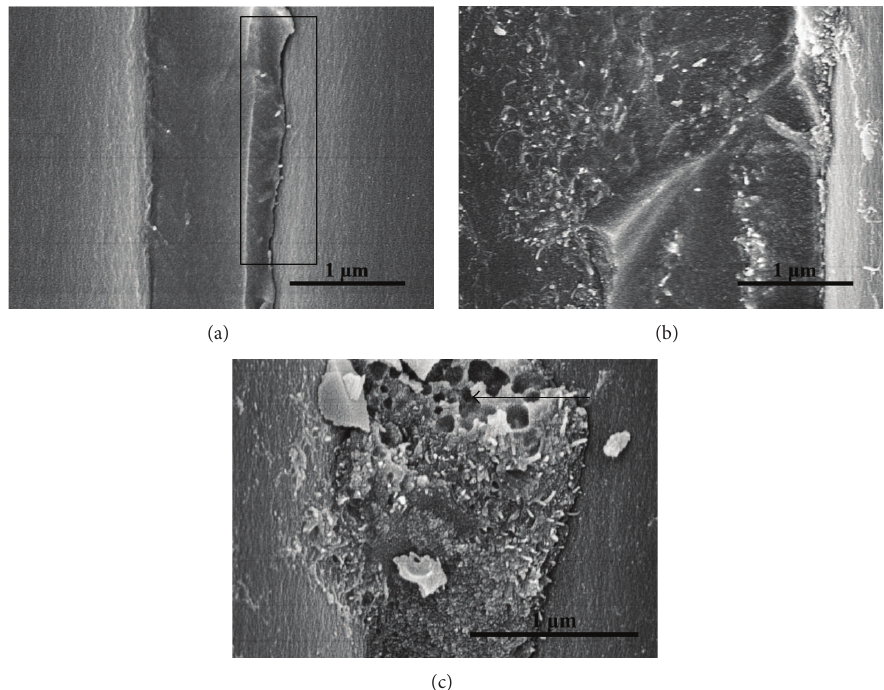
Figure 3: SEM images of the fracture surface of composites that failed in shear of (a) C f /SiC, (b) C f /1%CNTs/SiC, and (c) C f /2.5%CNTs/SiC.